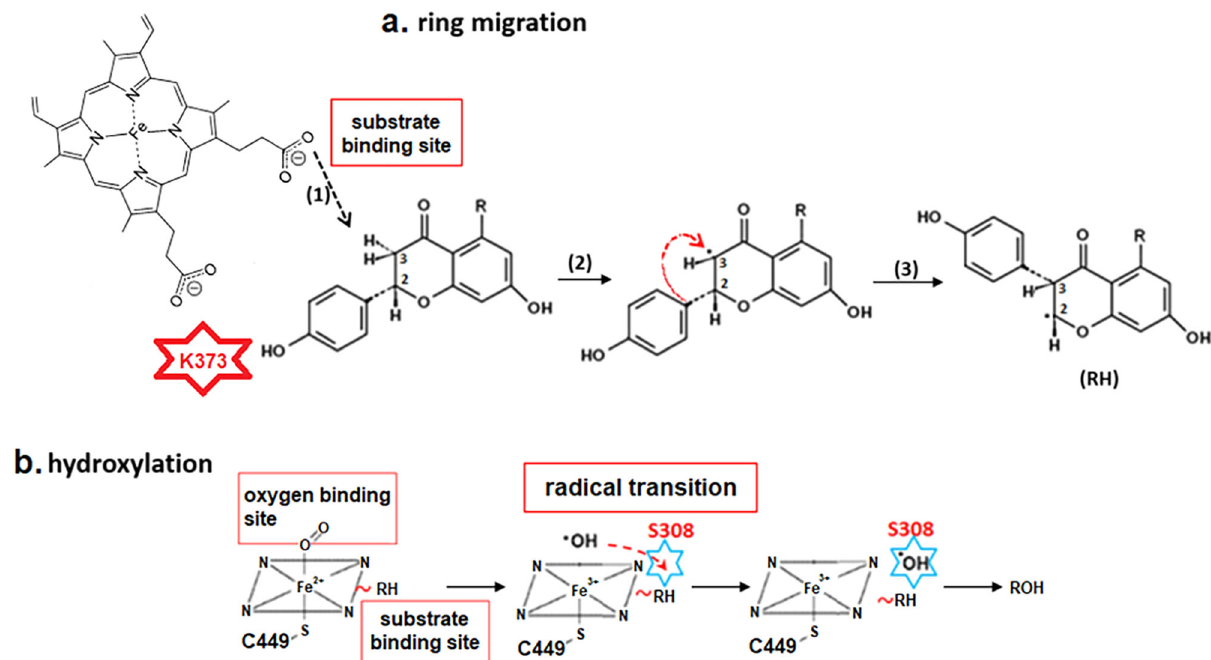
Fig. 6 Proposed 2-HIS reaction mechanism. a Ring migration: Substrate binds near heme propionate groups (1); heme carboxylate abstracts 3 β -hydrogen to deprotonate C3 (2); and B-ring moves from C2 to C3 (3). b Hydroxylation: The dioxygen is bound to the heme iron in the “ oxygen binding site ” ; after the hydroxyl radical is generated, it would be transferred to the “ hydroxyl radical transition site ” near the heme propionate groups under Ser308, then fi nally transferred from the activated oxygen intermediate to the C2 atom after the migration of the phenyl B-ring from C2 to C3.